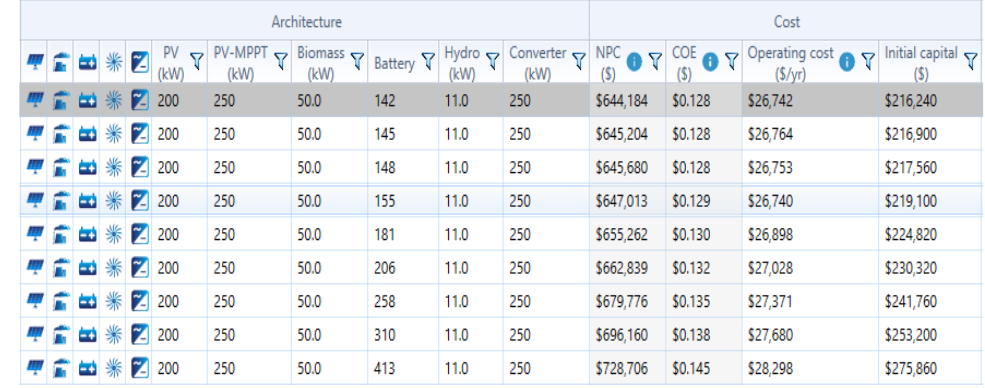
Figure 22. Total cash-flow study for case III (Ba/H/S).